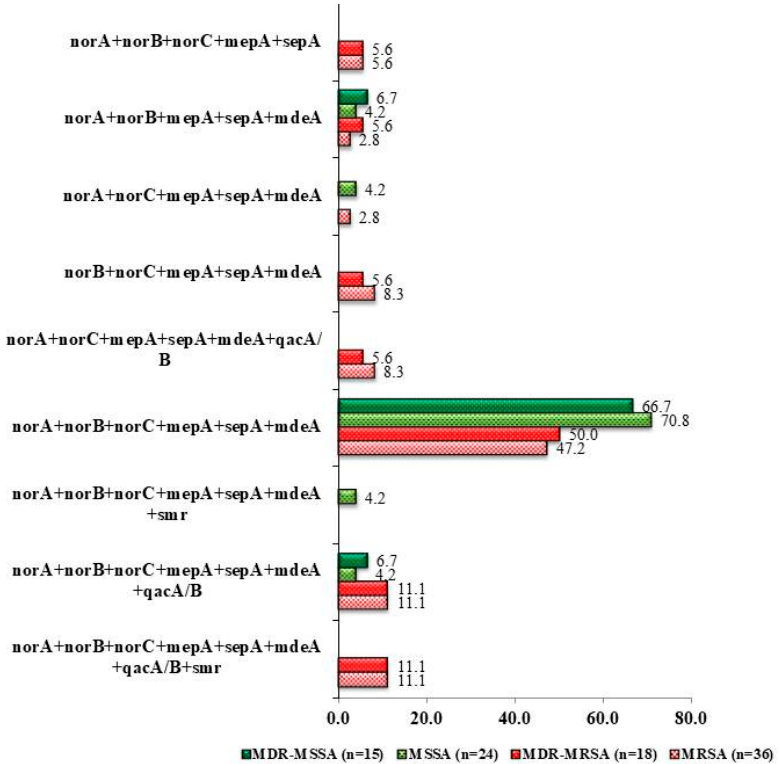
Figure 4. Prevalence of different combinations of genes present in the collected clinical isolates of S. aureus.